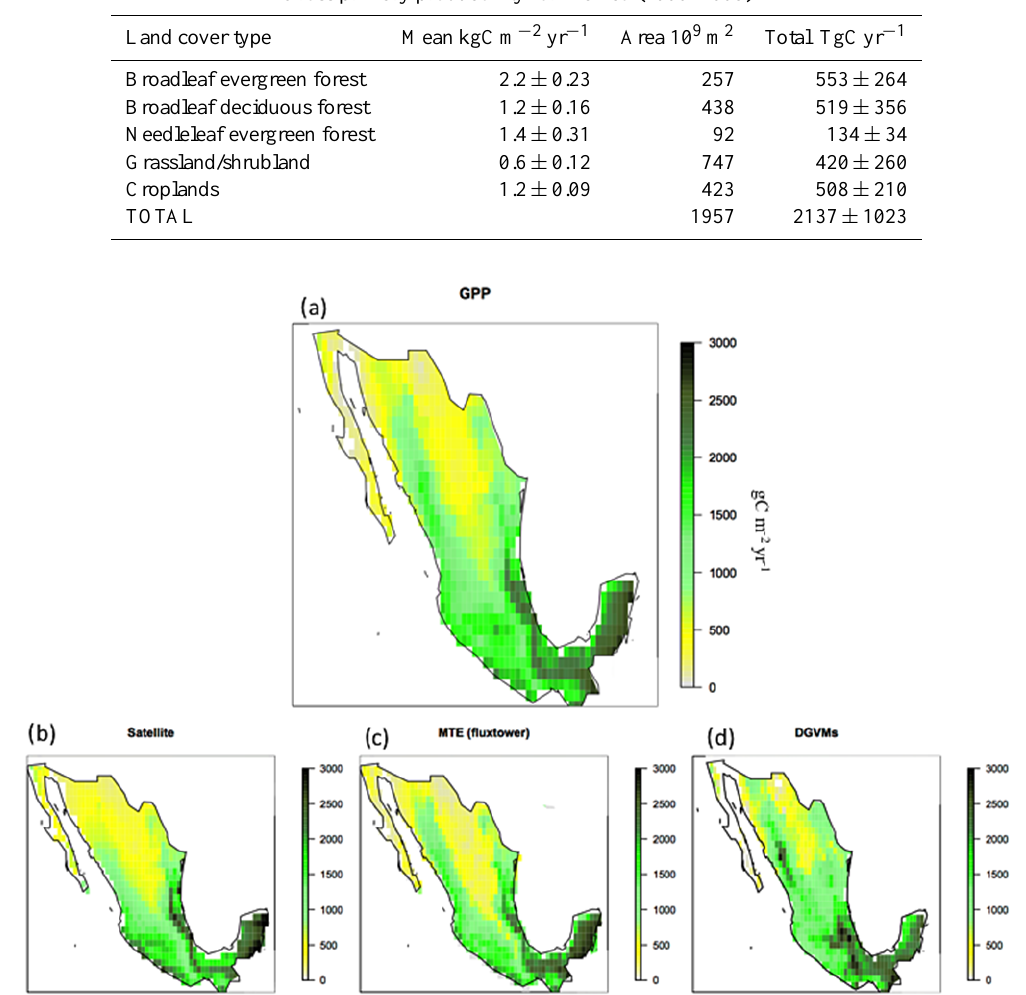
Figure 2. Mean GPP (gCm − 2 yr − 1 ) for (a) ensemble of the three products, (b–d) individual products (Satellite, MTE and DGVMs). All maps correspond to the period